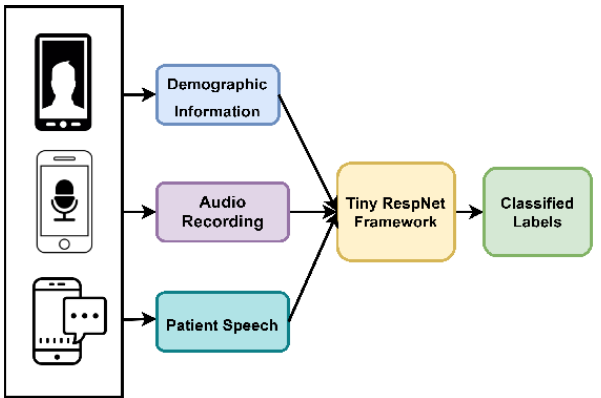
Figure 11. The Tiny